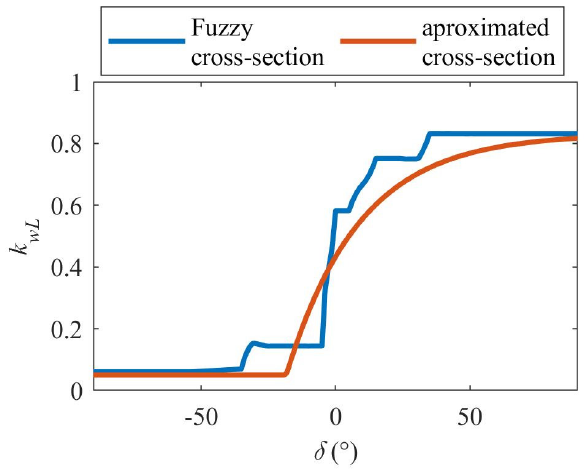
Figure 12. Rise angle δ n course of fuzzy control surface along the D axis at constant displacement angle δ 0 = − 20°.